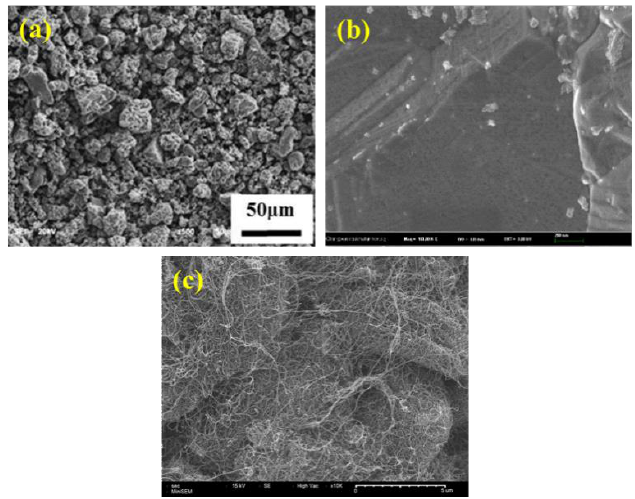
Figure 1. ( a ) SEM micrographs of the raw material copper (Cu), ( b ) FESEM micrographs showing the surface of the Cu powder and ( c ) multi-walled carbon nanotube (MWCNT).